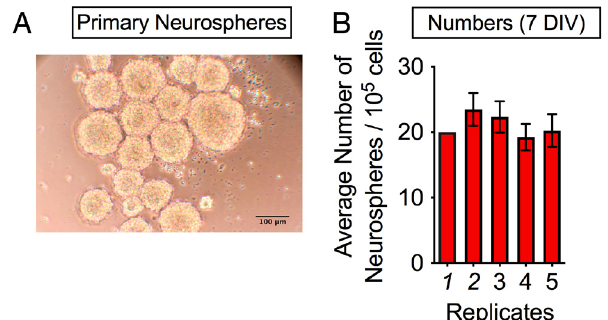
Figure 2. Primary neurospheres generated from the dorsal lateral ventricle. ( A ) Average size of primary neurospheres per field of view after 7 days in vitro . ( B ) Average number of neurospheres per field of view after 7 days in vitro (N=5). Scale bar = 100 μm.